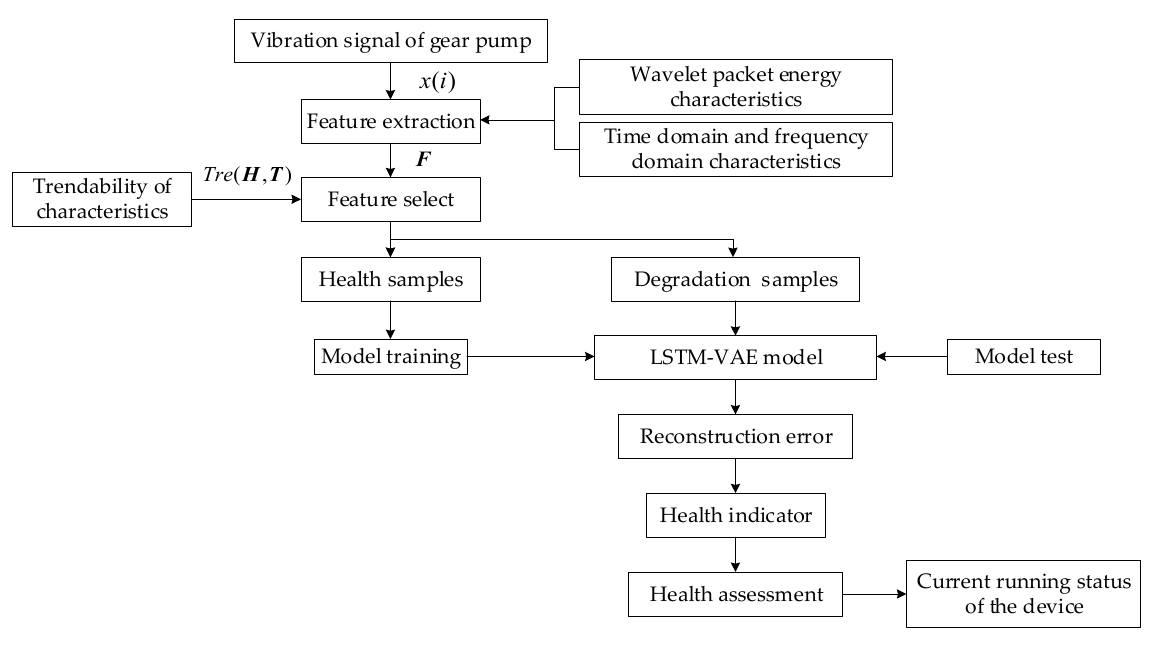
Figure 5. Health assessment process of gear pump.